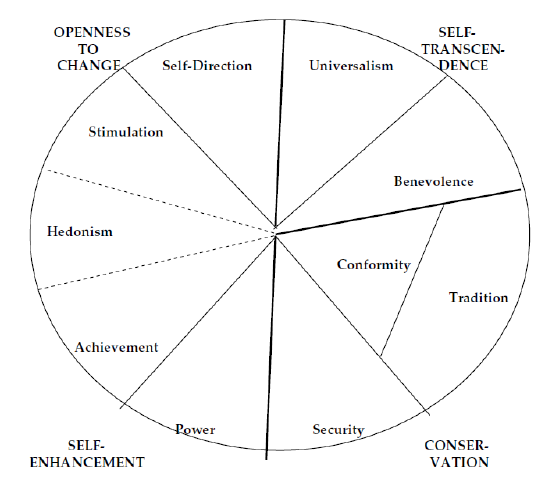
Figure 1 . Schwartz’s values model (Schwartz,